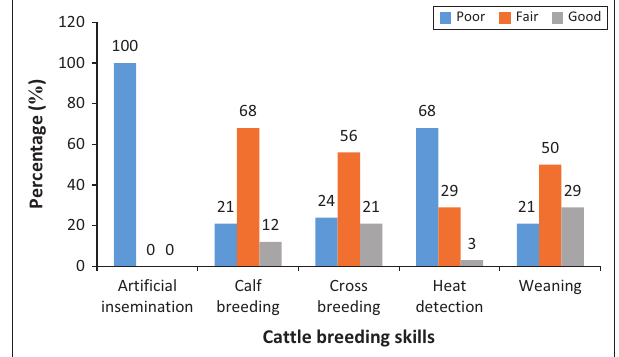
TABLE 2: Factors that could hinder commercial cattle farming, as identified by respondents. Factors that could hinder cattle farming